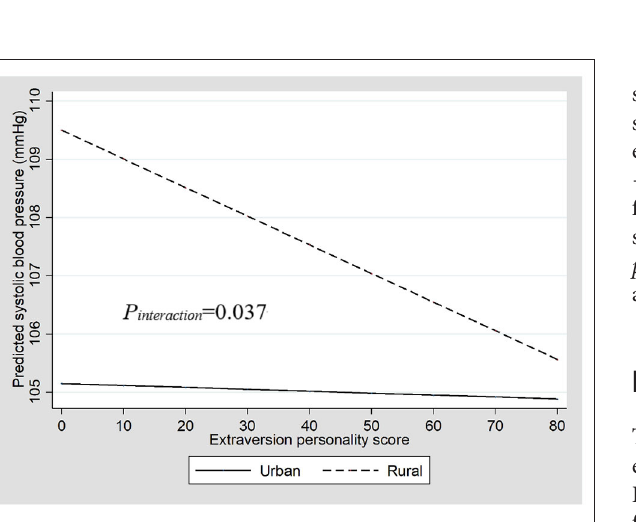
FIGURE 2 | The interaction between extraversion personality and region on a systolic